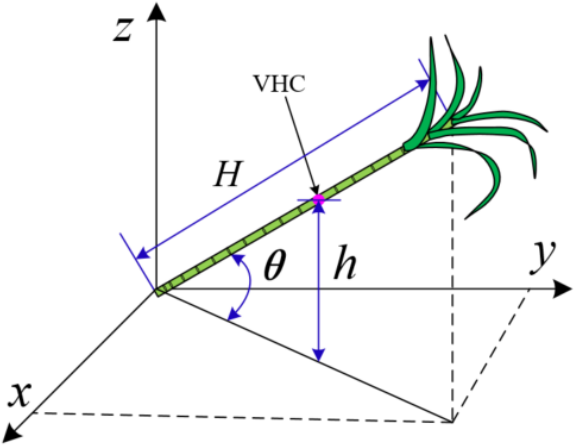
Figure 6. Calculation of VHC.